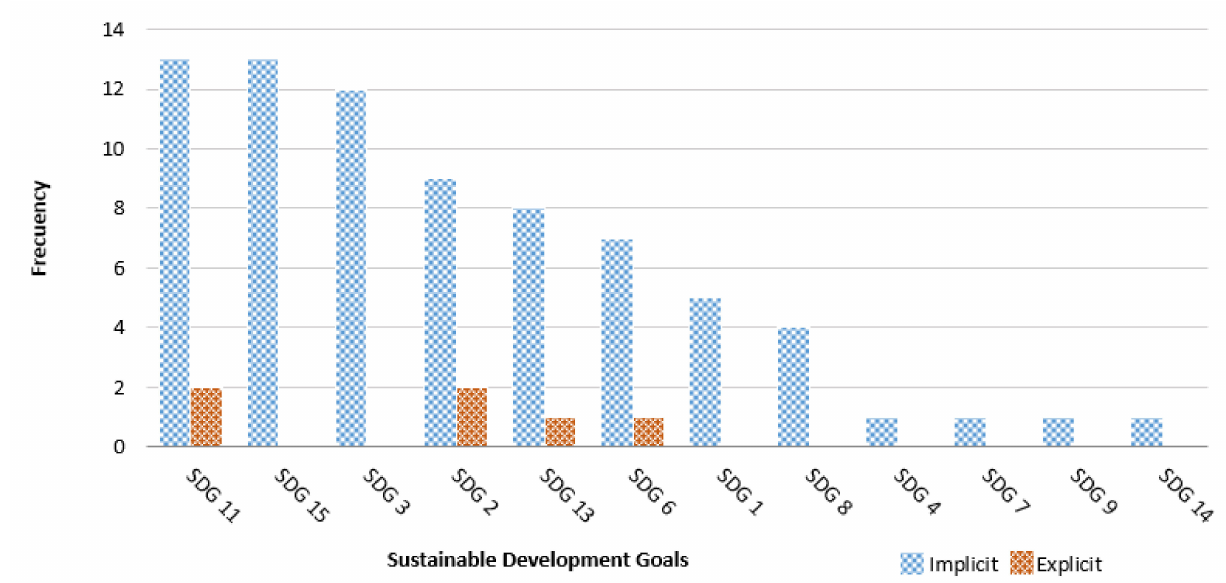
Figure 7. Explicit and implicit reference to the SDGs in the